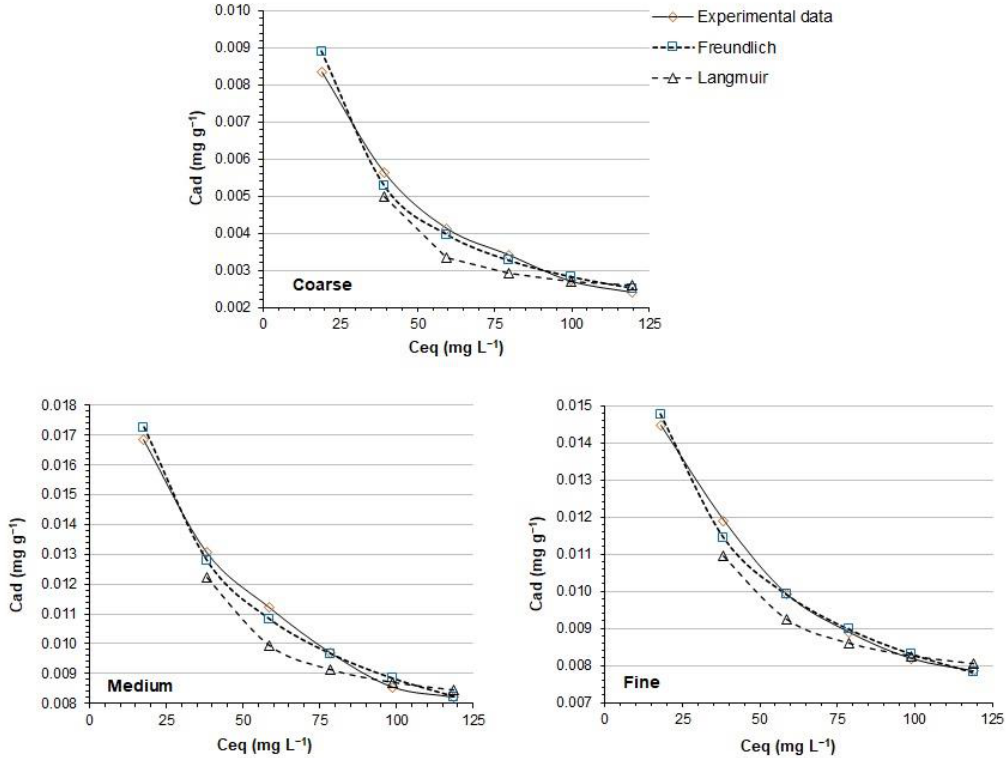
Figure 7. Adsorption isotherms for nitrate ions on the adsorbent substrates prepared with the three granulometric fractions of material and activated with HCl.